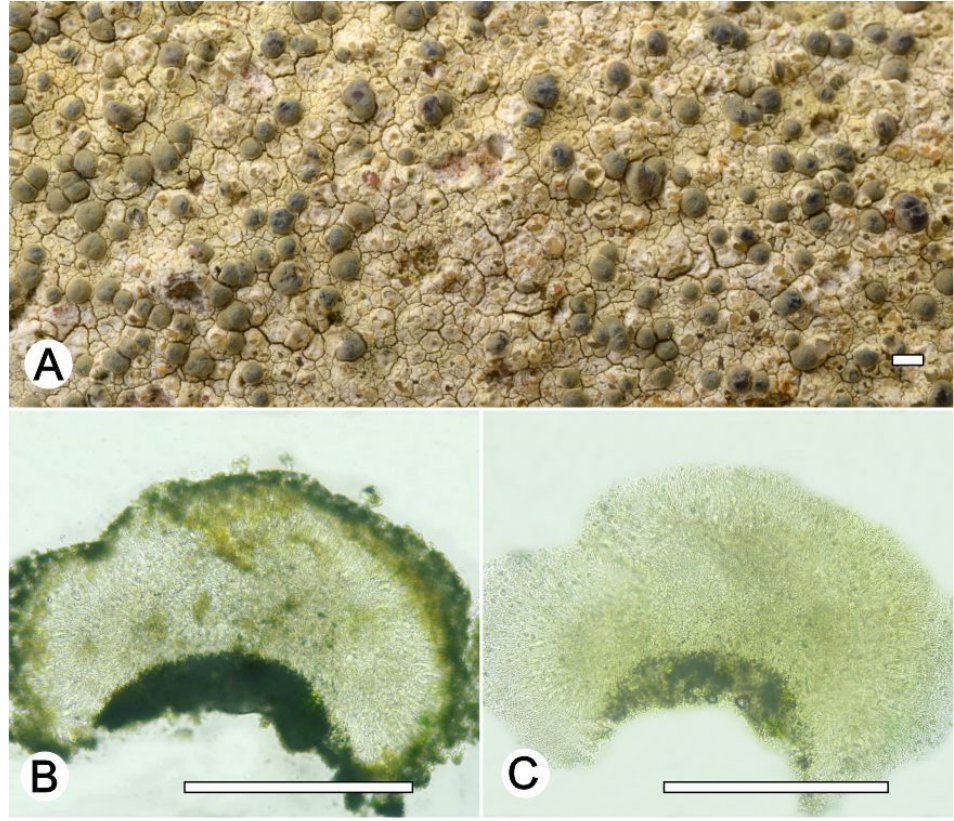
Figure 3. Lecanora fluorosaxicola sp. nov. ( A ) Thallus with ascomata (holotype, ISE-54033); ( B , C ) Apothecial section after KOH treatment (holotype ISE-54033). Scale bars: ( A ), 1 mm; ( B , C ), 100 µm. Lecanora glaucomodes Nyl. (Figure 4)